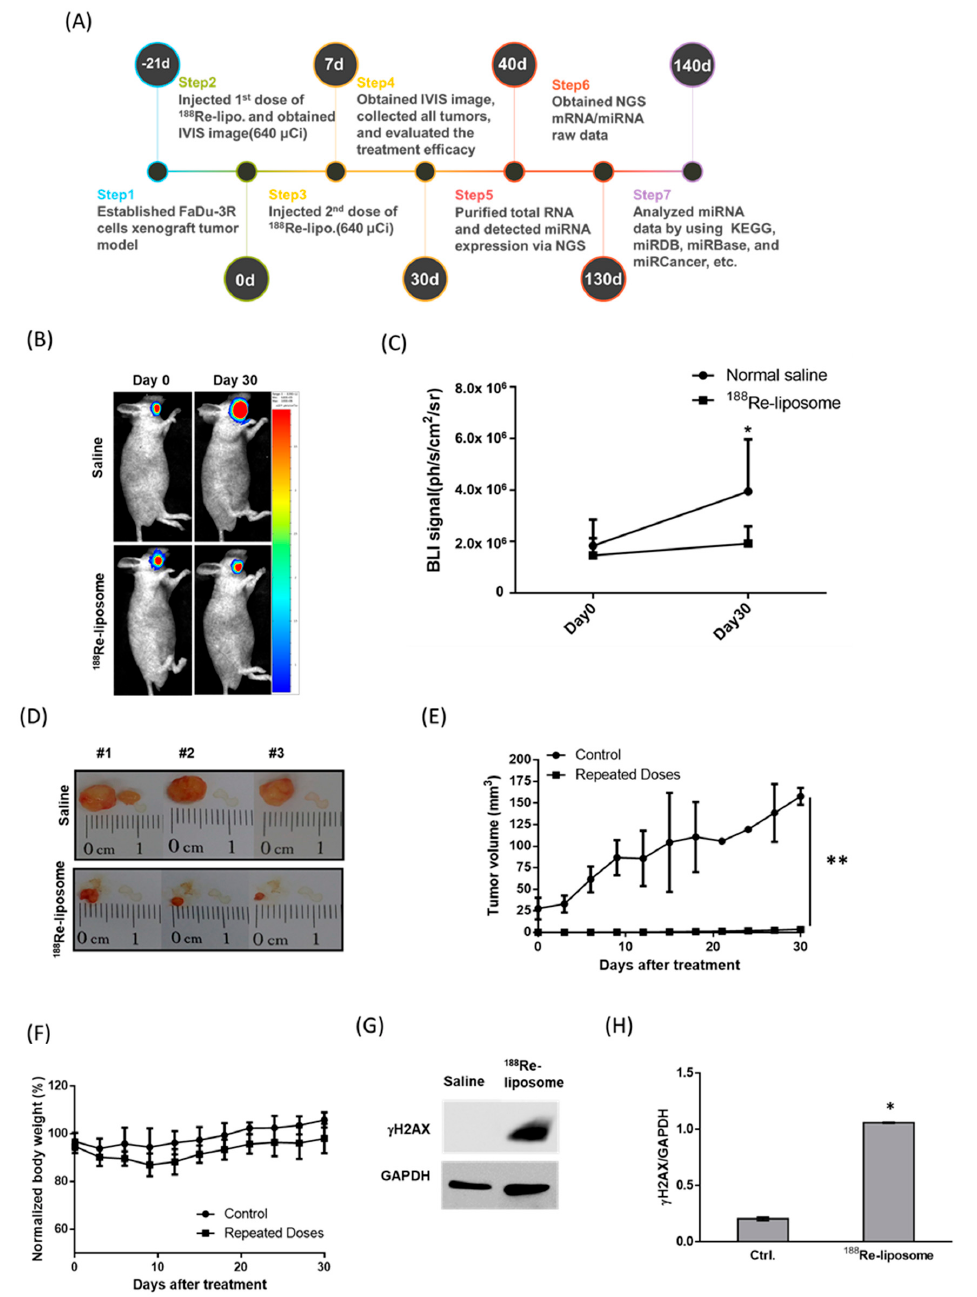
Figure 2. Comparison of PEGylated 188 Re-liposomal accumulation in orthotopic hypopharyngeal cancer (HPC) tumors after repeated injections. ( A ) The experimental scheme for 188 Re-liposome treatment and analysis. ( B ) Reporter gene imaging of tumor growth responding to repeated doses of 188 Re-liposome, and the saline-treated control. ( C ) Quantification of bioluminescent imaging (BLI) signals. *: p < 0.05. ( D ) Representative photos of excised orthotropic tumors with or without the treatment of 188 Re-liposomes. ( E ) Caliper measurement of tumor volumes. Data are represented as means ± S.D. **: p < 0.01. ( F ) Measurement of body weights of mice. ( G ) Comparison of the γ -H2AX protein expression in tumors with or without the treatment of 188 Re-liposomes. ( H ) Densitometric quantification of Western blots. *: p < 0.05.